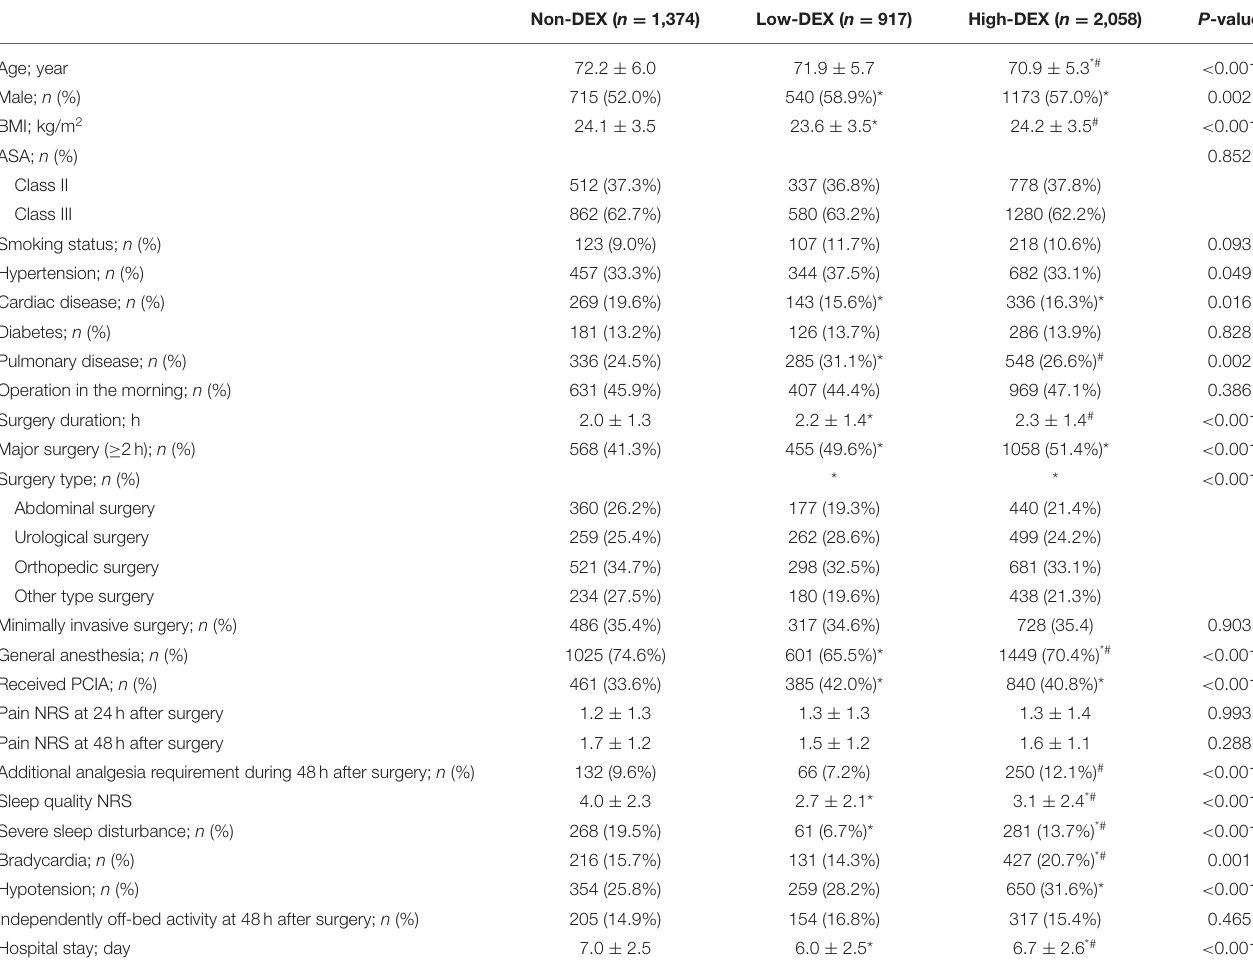
TABLE 1 | Clinical characteristics at baseline and postoperative outcomes between the Non-DEX, Low-DEX, and High-DEX patient